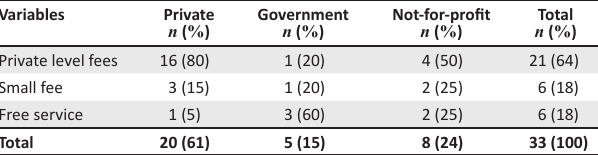
TABLE 7: Speech and language therapists: Role categories and examples. SLTs: Role categories